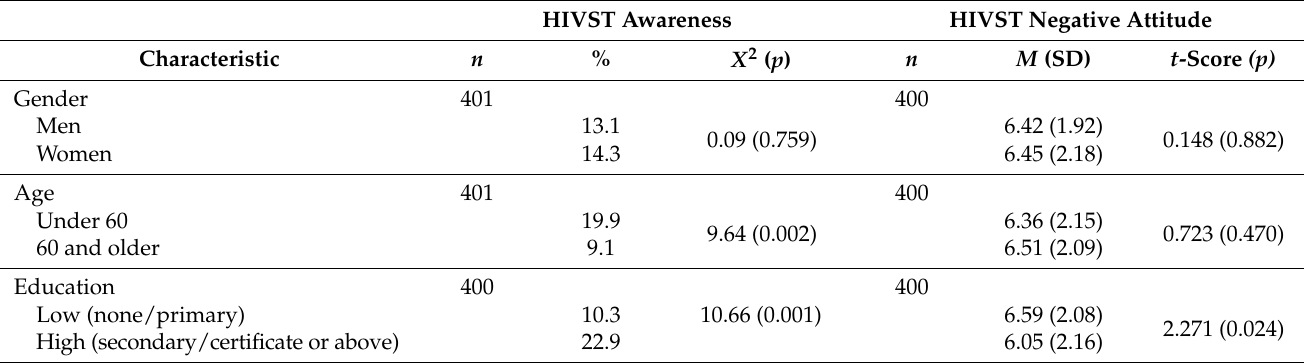
Table 4. Bivariate relationships between demographic characteristics and both HIVST awareness and negative attitudes. HIVST